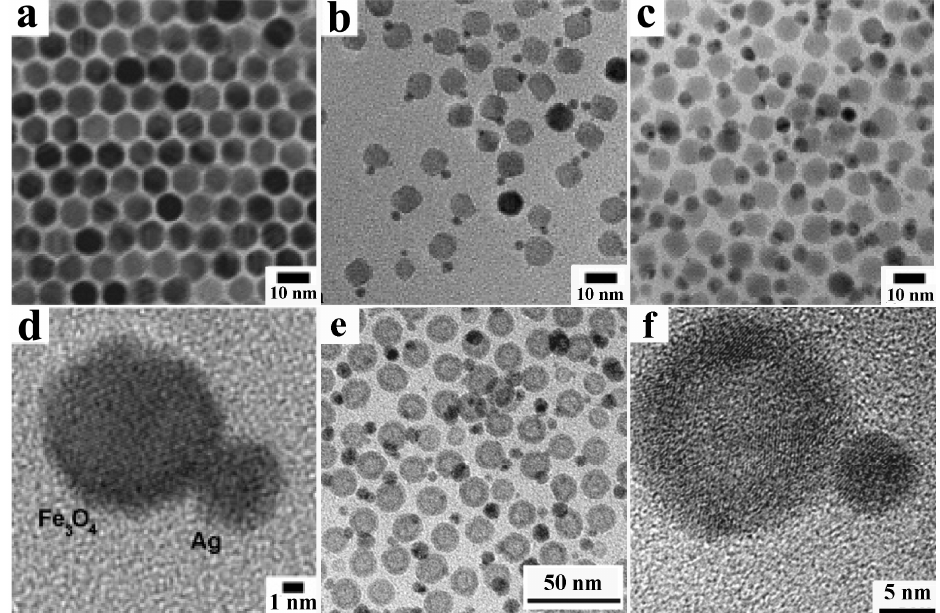
Figure 8. Gallery of representative heteromeric CNHSs produced at liquid/liquid interfaces (cf. Scheme 3b). The panels report variable-magnification TEM images of: ( a ) the starting Fe 3 O 4 seeds and ( b – d ) Fe 3 O 4 –Ag hetero-dimer CNHSs thereof with different Ag domain sizes (reproduced with permission from Ref. [295], Copyright 2005, American Chemical Society); ( e,f ) Fe 3 O 4 –Ag hetero-di- mer CNHSs with hollow Fe 3 O 4 domain (adapted with permission from Ref. [296], Copyright 2010,